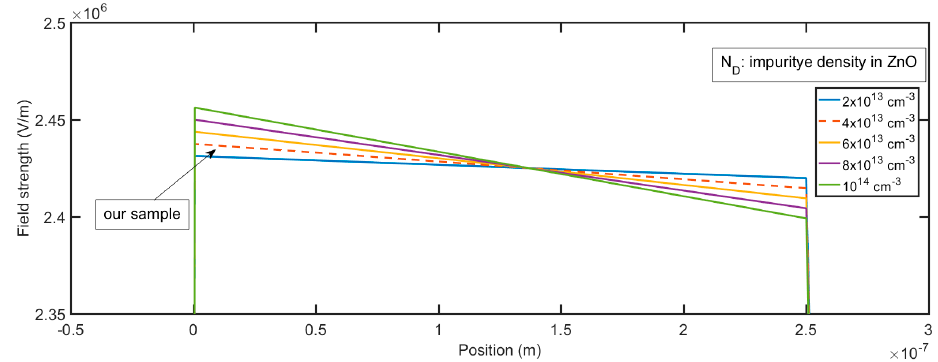
Figure 7. Field profile p-Si/i-ZnO/n-AZO structure for different impurity concentrations of i-ZnO layer.